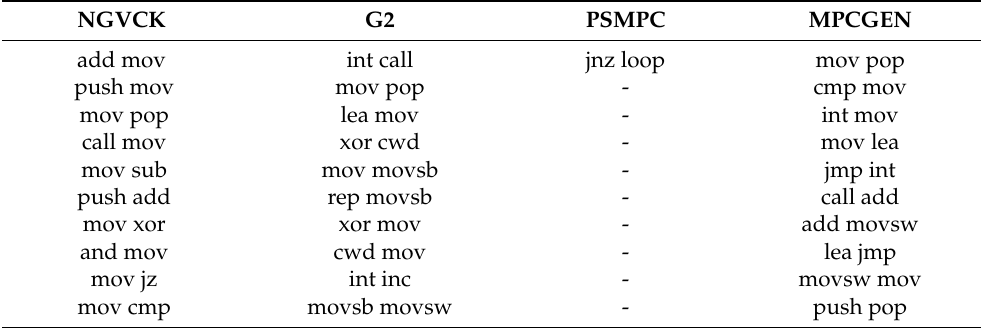
Table 9. Replacement of opcodes for malware generator (NGVCK, G2, PSMPC, and MPCGEN). For all generators, mov , push , pop , and jump instructions are replaced. NGVCK